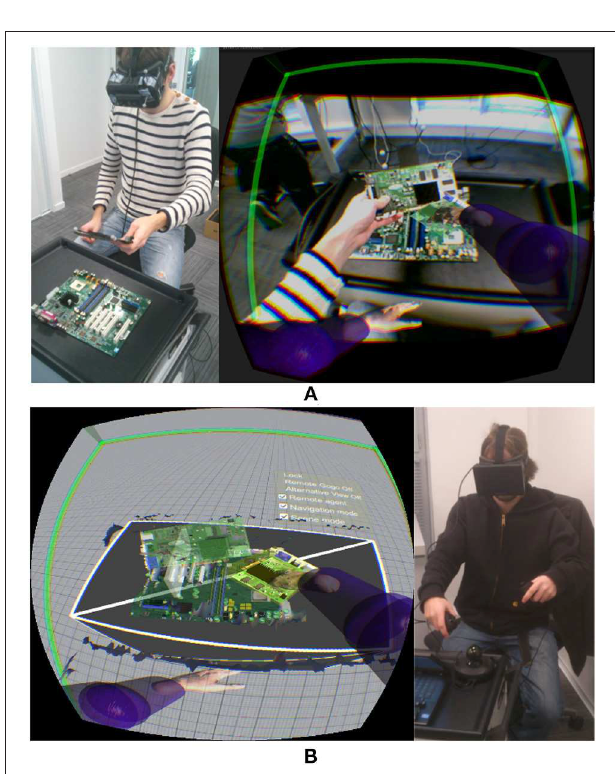
FIGURE 3 | Illustration of the system and the viewpoints of (A) the agent and (B) the expert for a motherboard assembly task.